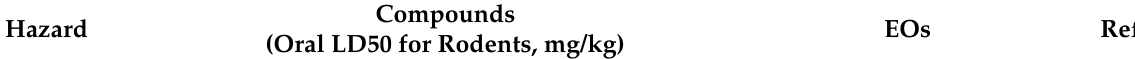
Table 1. Major hazards for human health of compounds and EOs. Molecules with herbicidal activities are underlined.